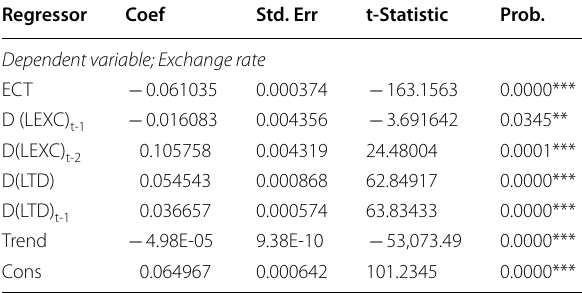
Table 8 Short-run estimates based on PMG for Brazil